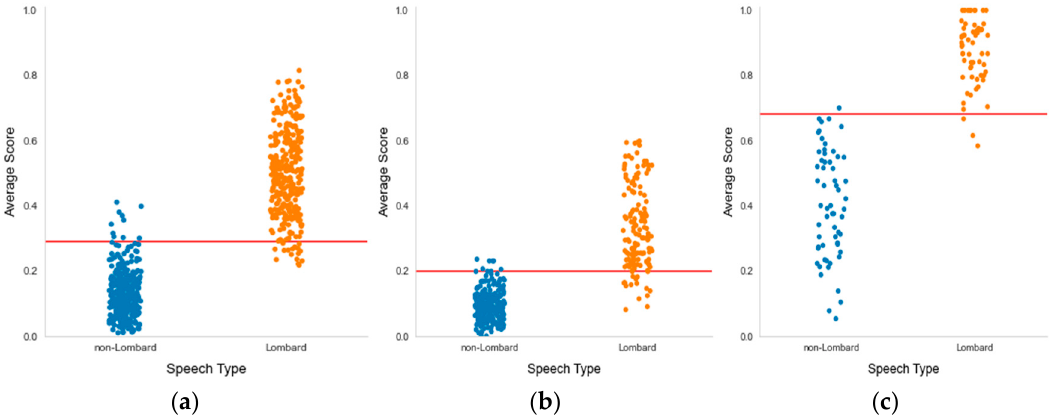
Figure 11. Separation plots for ( a ) the G1 model with a cutoff level of 0.29, ( b ) the G2 model with a cutoff level of 0.2, and ( c ) the P1 model with a cutoff level of 0.68. cutoff level of 0.2, and ( c ) the P1 model with a cutoff level of